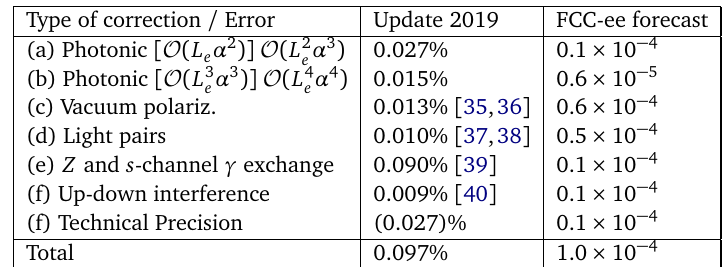
Table 1: Anticipated total (physical + technical) theoretical uncertainty for a FCC-ee luminosity calorimetric detector with the angular range being 64–86mrad (narrow), near the Z peak. Description of photonic corrections in square brackets is related to the 2nd column. The total error is summed in